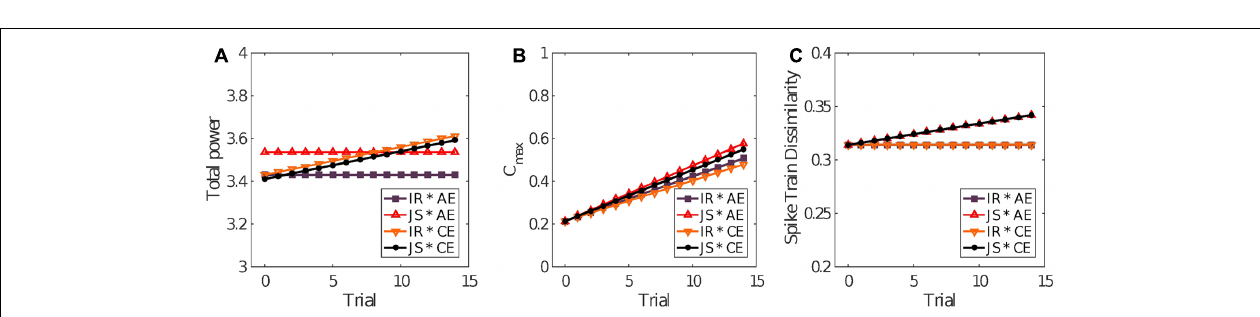
FIGURE 6 | Model predictions. The linear mixed-effects model fits for the four scenarios determined by trial outcome according to clicks made (joint success or individual response) and the self-reported experience (clear or ambiguous). (A) The final models for total power, (B) cross-correlation, and (C) SPIKE-distance are shown. IR, individual response; JS, joint success; AE, ambiguous experience; CE, clear experience.